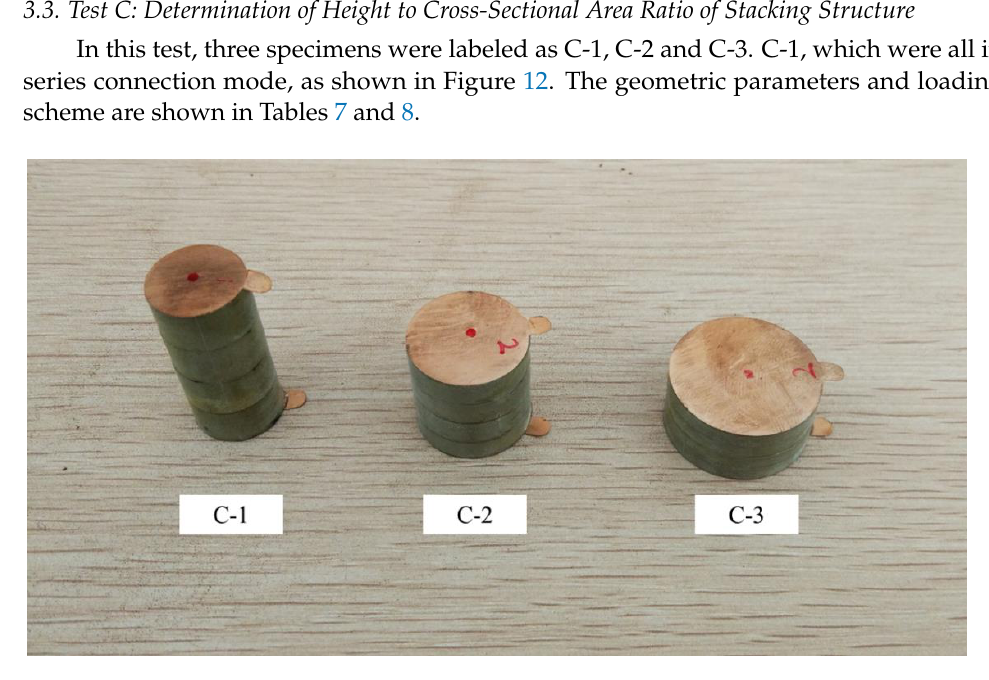
Figure 12. The specimens of test C. Table 7. Size parameters of the specimens in Test C.